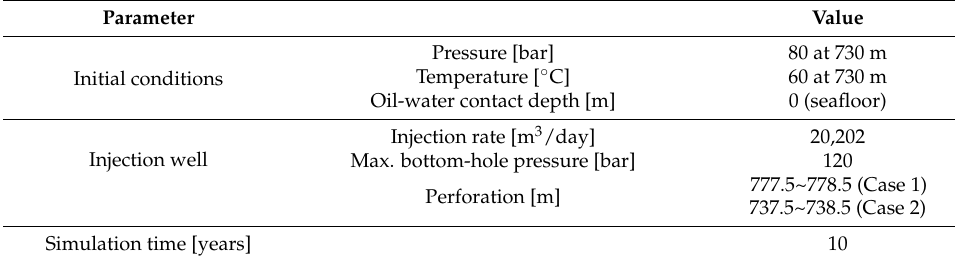
Table 3. Input parameters for numerical modelling of CO 2 flow.